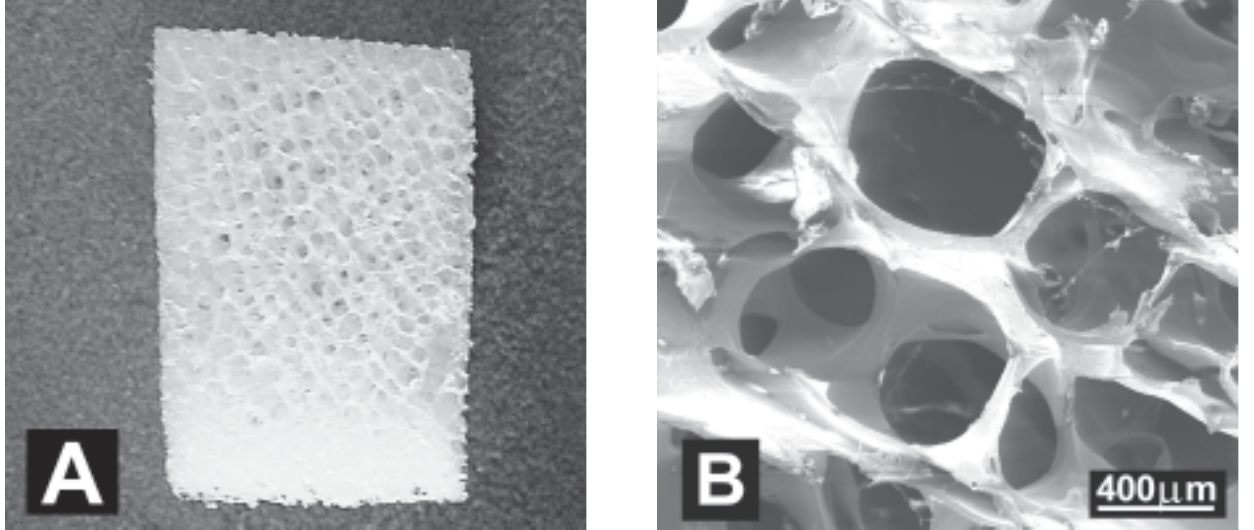
FIGURE 1.- Macroscopic ( A ) and scanning electron microscopic ( B ) views of organic bovine bone in block showing various interconnected pores